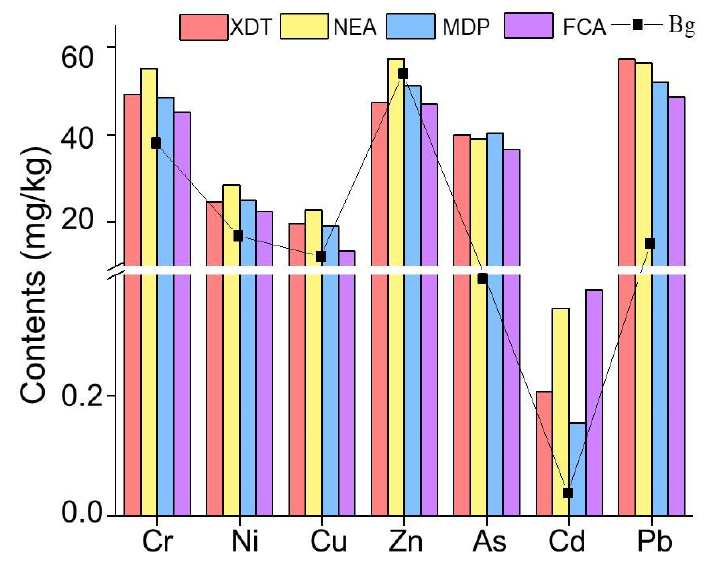
Figure 2. The contents of PTEs in sediments of the Wuliangsuhai wetland.